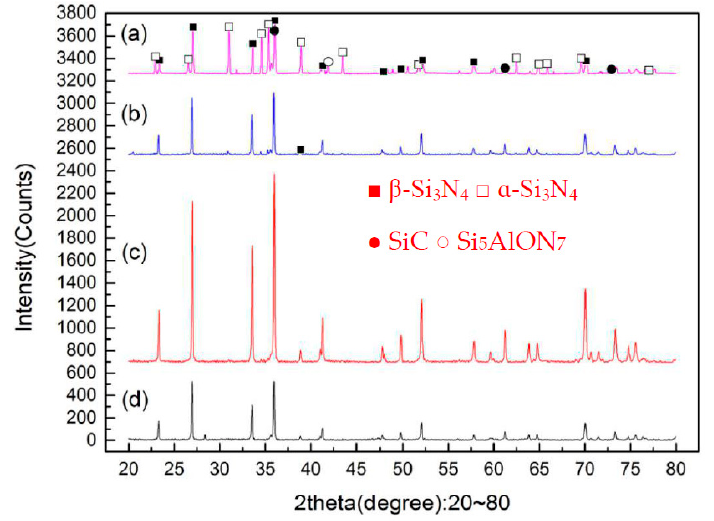
Figure 5. The X-ray diffraction (XRD) results of the sintered Si 3 N 4 /n-SiC ceramics at different sintering temperatures (holding time for 10 min), ( a ) 1400 °C, ( b ) 1500 °C, ( c ) 1600 °C, and ( d ) 1700 °C.